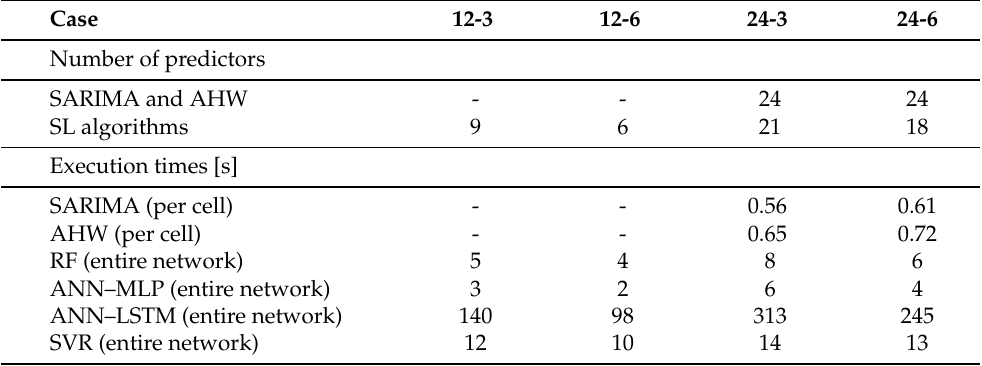
Table 6. Execution times